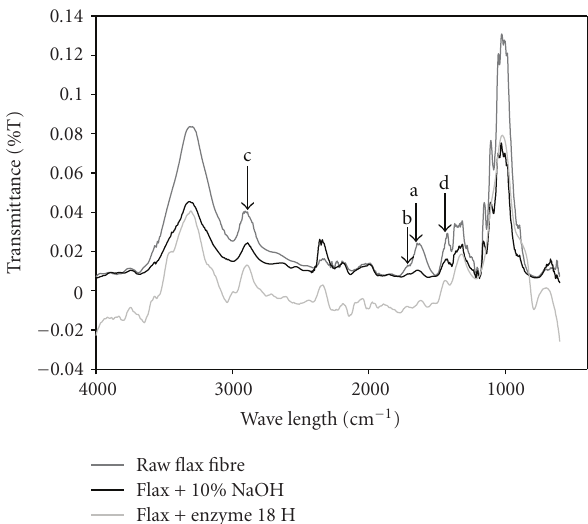
Figure 4: ATR-IR spectroscopy of raw-, NaOH-, and Enzyme- treated flax fibres: (a) peak at 1615cm − 1 that corresponds to pectin; (b), (c) peaks at 1735cm − 1 and 2923cm − 1 , respectively, that correspond to hemicellulose; (d) peak at 1440cm − 1 that corresponds to lignin.